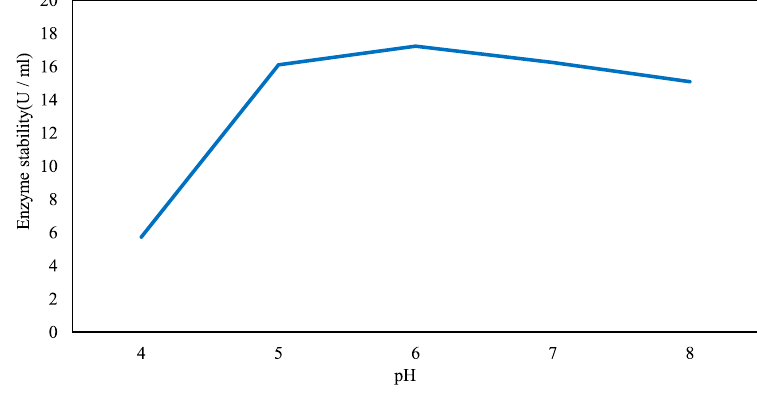
Fig. 12. Effect of different pH values on stability of the purified β-xylosidase